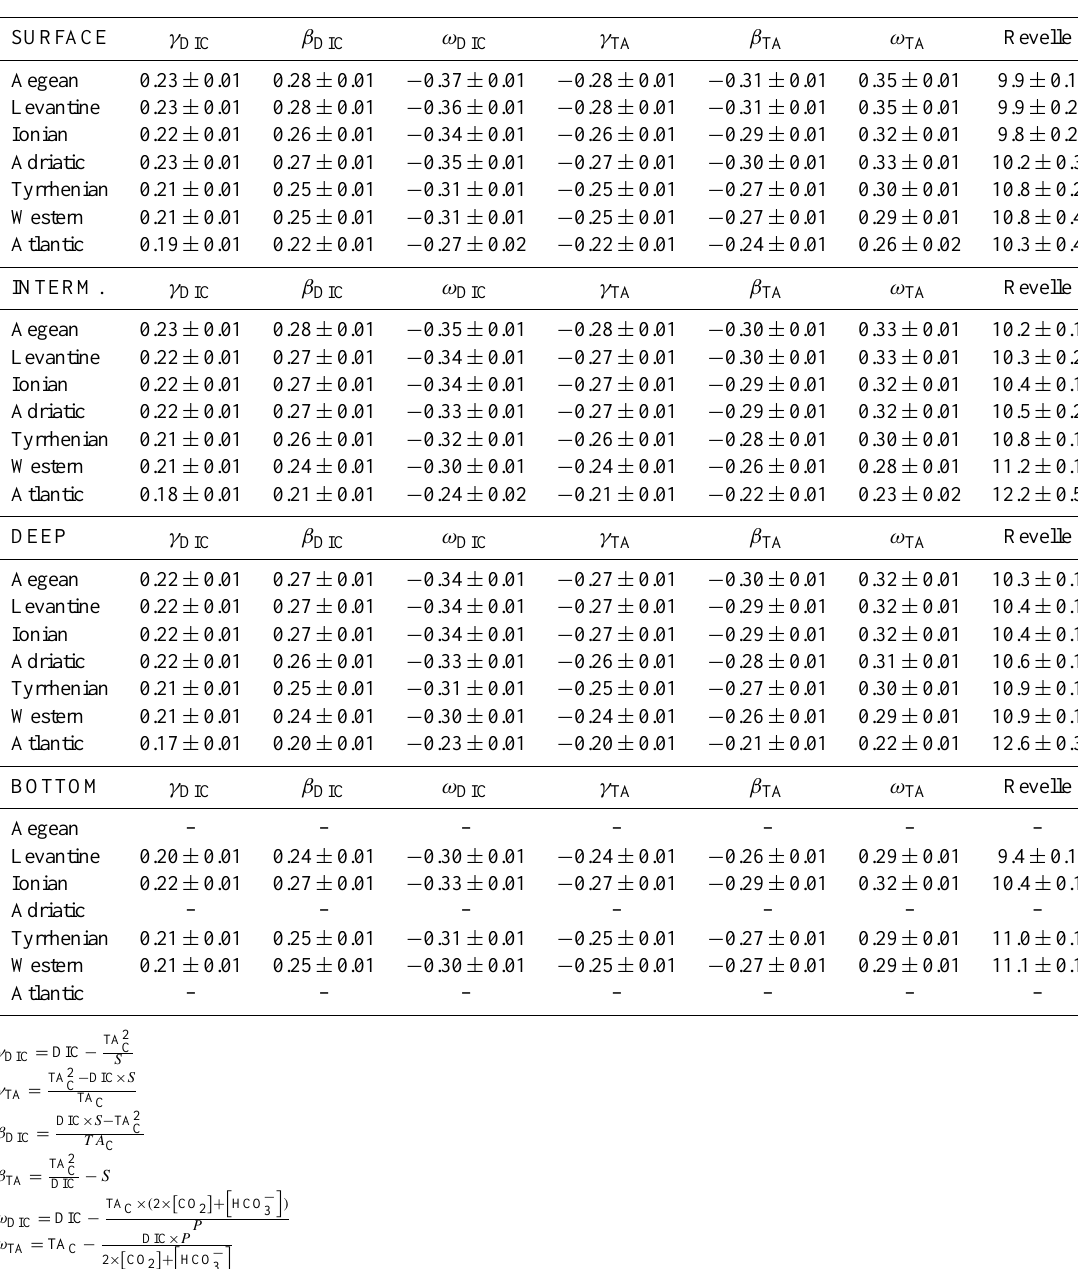
Table 3. Mean values and standard deviation of several buffer factors in the different MedSea sub-basins and west of the Strait of Gibraltar as sampled during the M84/3 cruise. Same vertical intervals as in Table 2. The buffer factors have units of mmolkg − 1 and Revelle is